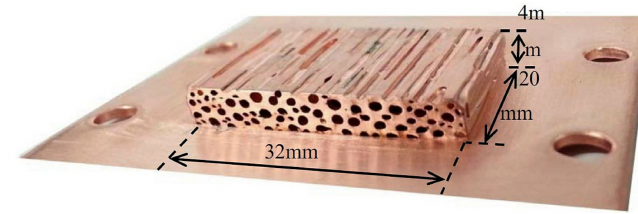
Figure 17. Lotus-type copper heat sink. Fluid flows through the pores and heat flows from the bottom into the structure. Reproduced from [2], with permission from Elsevier, 2015.